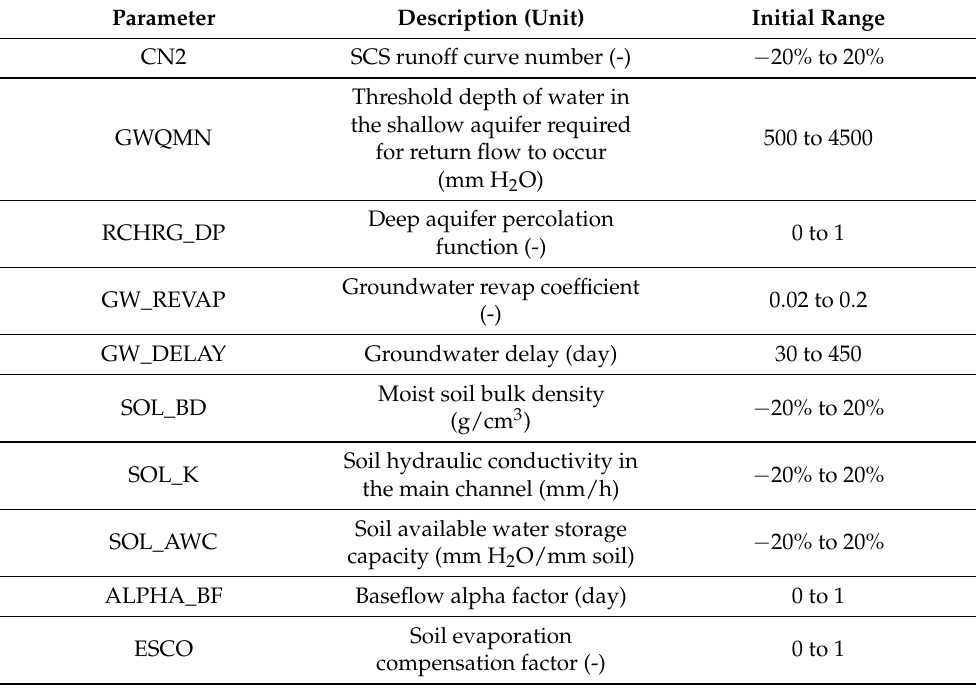
Table 3. Parameters used for sensitivity